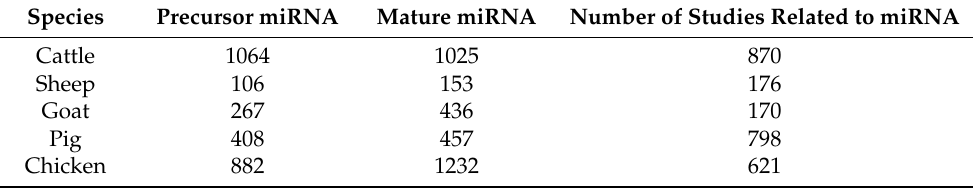
Table 1. Number of detected miRNAs and miRNA-related studies in some farm animal species *. Species Precursor miRNA Mature miRNA Number of Studies Related to miRNA Cattle 1064 1025 870 Sheep 106 153 176 Goat 267 436 170 Pig 408 457 798 Chicken